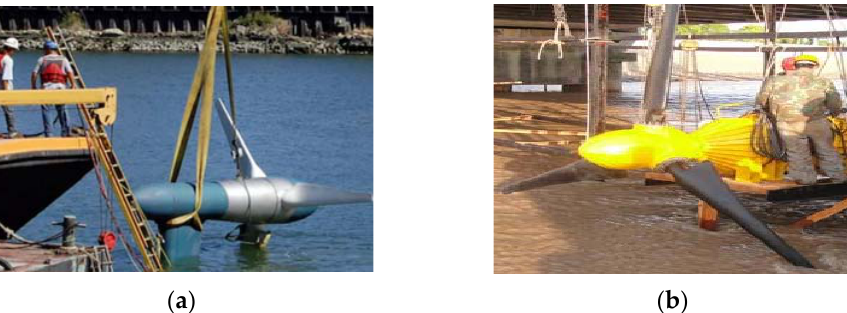
Figure 1. ( a ) Water Turbine of Verdant Power, USA [1]; ( b )Water Turbine Device of Zhejiang University [2].